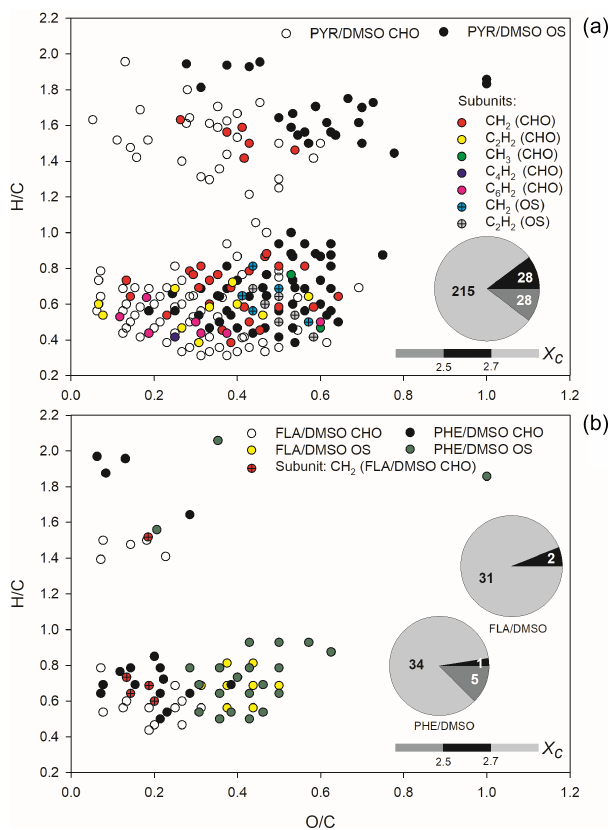
Figure 3. The van Krevelen (VK) graph and aromaticity equiv- alent (grey with X c < 2.5, black with 2.5 ≤ X c < 2.7, and silver with X c ≥ 2.7) for the detected CHO and CHOS compounds in ESI − mode, formed upon light-induced heterogeneous reaction of SO 2 with PAHs/DMSO. The X c value is illustrated by the colour bar of each VK diagram, while the pie chart shows the number in different X c intervals during these